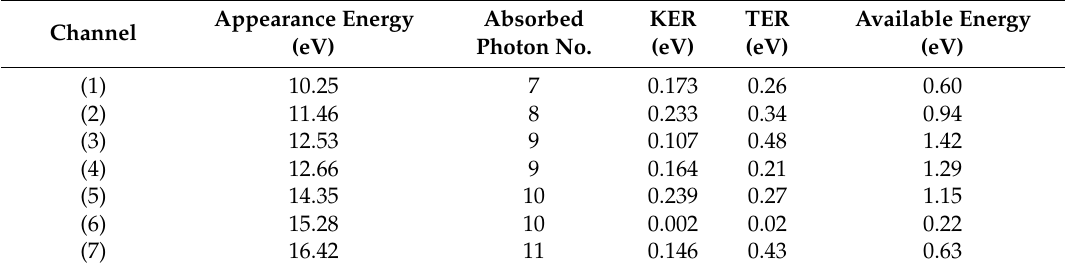
Table 1. The kinetic energy distributions (KER), the minimum number of 800 nm photos, the transnational kinetic energy release (TER) of the corresponding photo-dissociation channel, the corresponding appearance energy and the available energy for different DI channels.